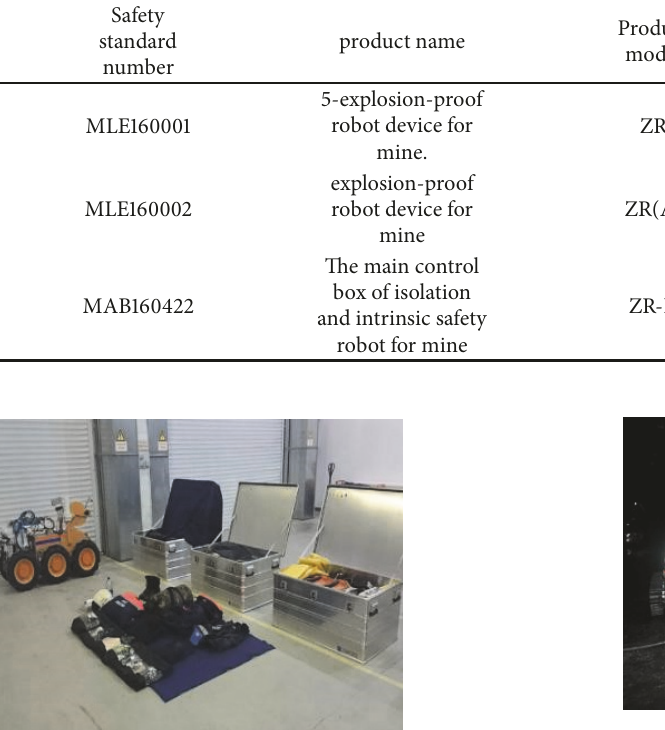
Figure 5: CUMT-V, a coal mine disaster rescue robot with the Coal Mine Safety